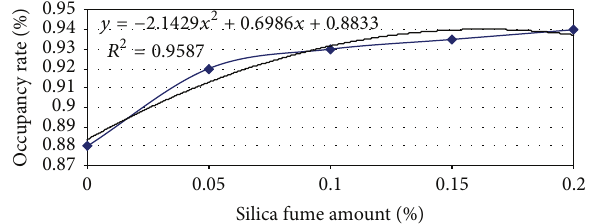
Figure 8: The relation between silica fume additive and occupancy in concrete with 40/60 fine/large aggregate ratios.